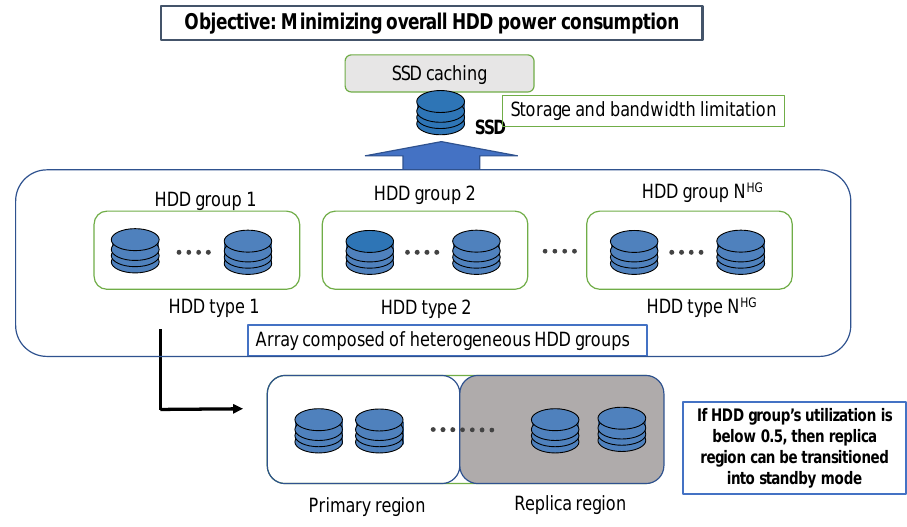
Figure 1. System